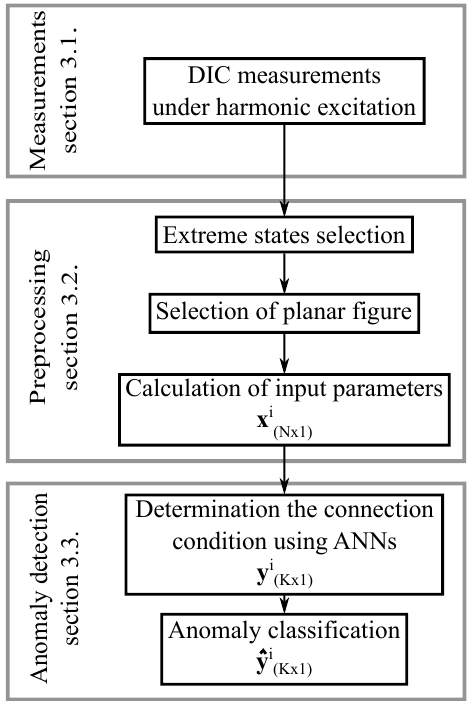
Figure 1. Scheme of the proposed